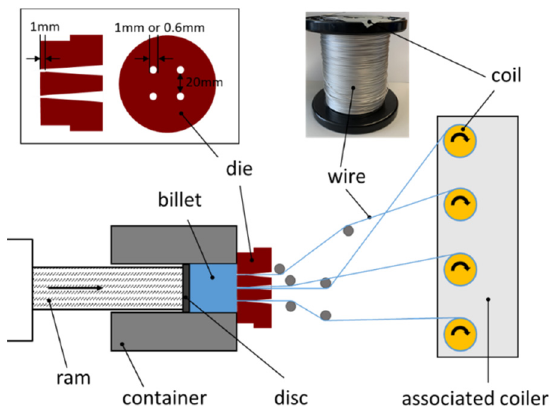
Figure 1. Schematic illustration of the wire extrusion process and the die.